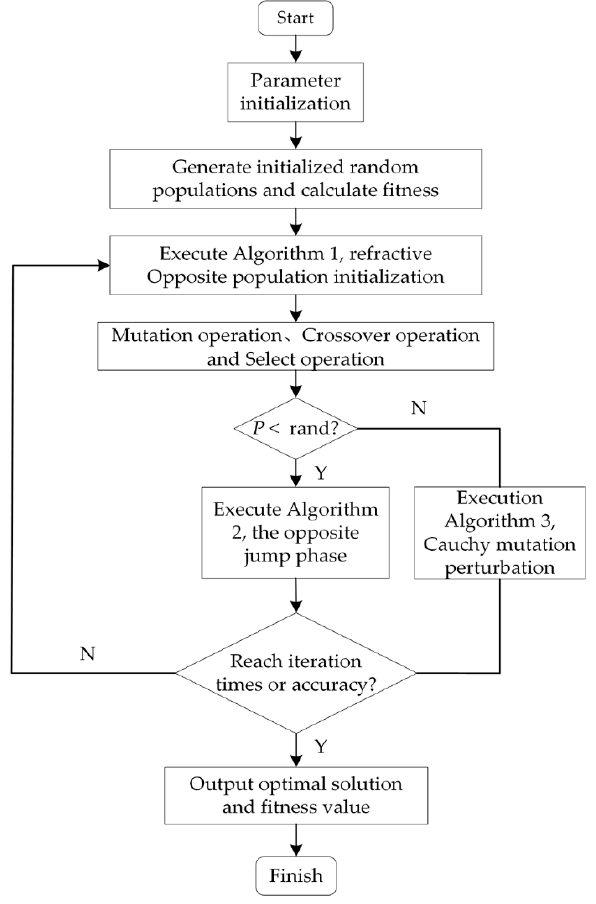
Figure 7. RCDE algorithm flow chart.